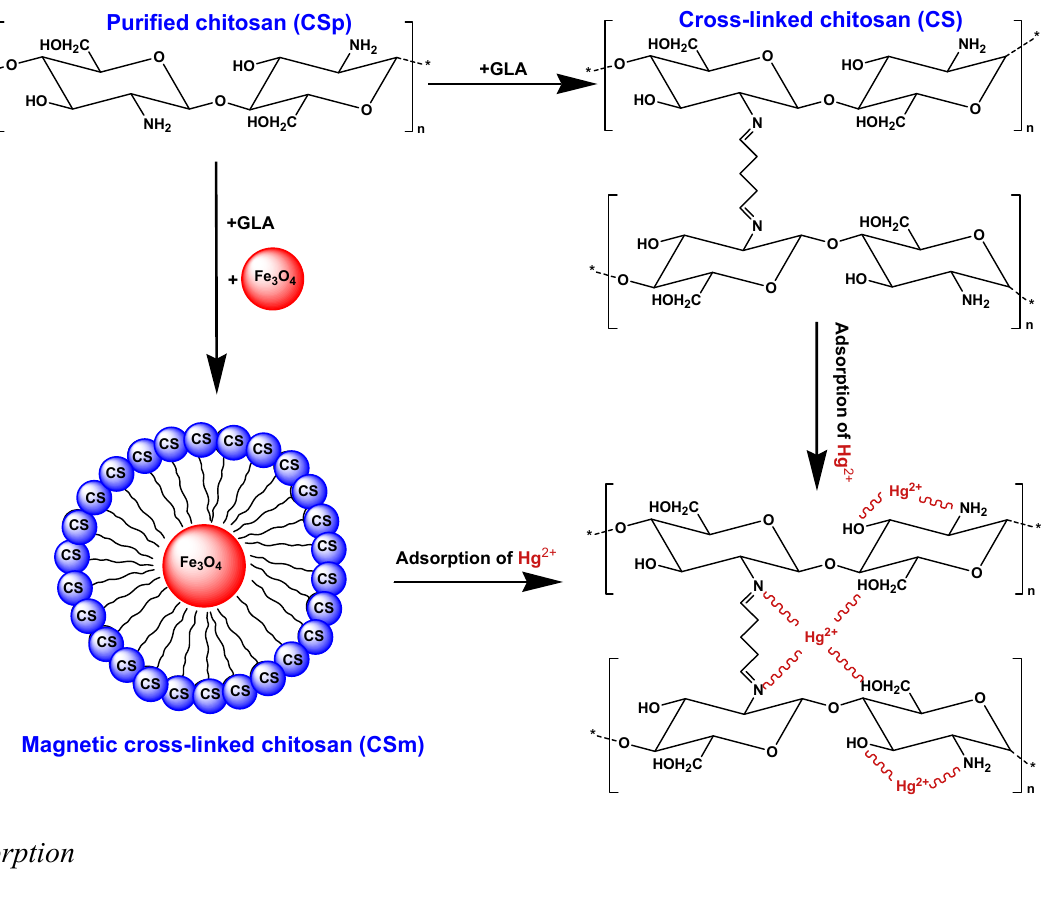
Figure 7. Preparation of CS and CSm and possible interaction with